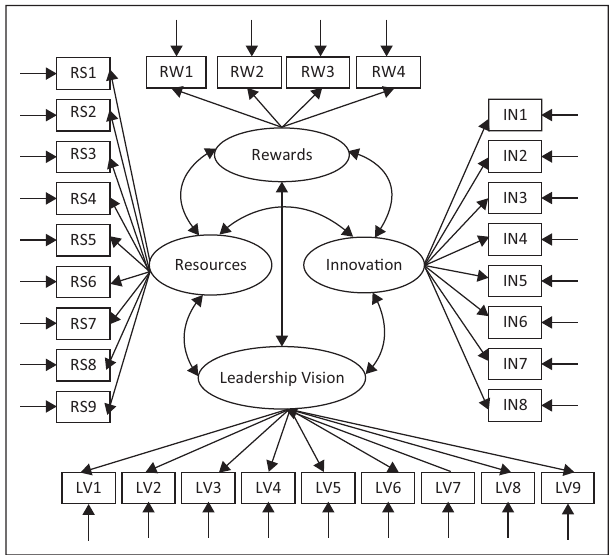
FIGURE 2: Hypothesised confirmatory factor analysis first-order leadership measurement model for